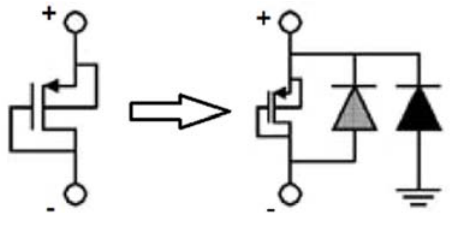
Figure 5 . The pseudo resistor used for (cid:1844) (cid:3043)(cid:2869) . Figure 5. The pseudo resistor used for R p 1